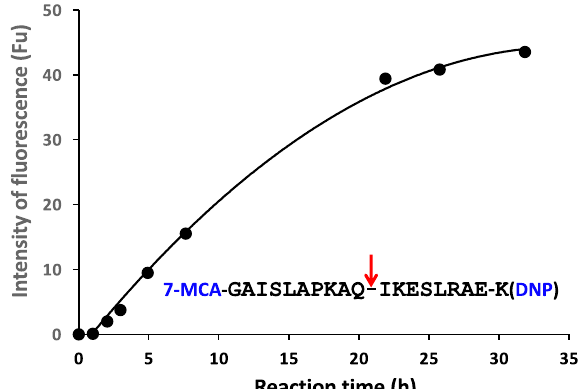
Figure 4. The time course for the cleavage of FRET-PD1 by H34wt: the cleavage reaction was performed with 5 µM H34wt using 25 µM of FRET-PD1 (PD-1; aa 123-140). The reaction was performed in duplicate. H34wt cleaves the FRET-PD1 peptide in a linear fashion up to 20 h of the reaction time, following which it reaches a